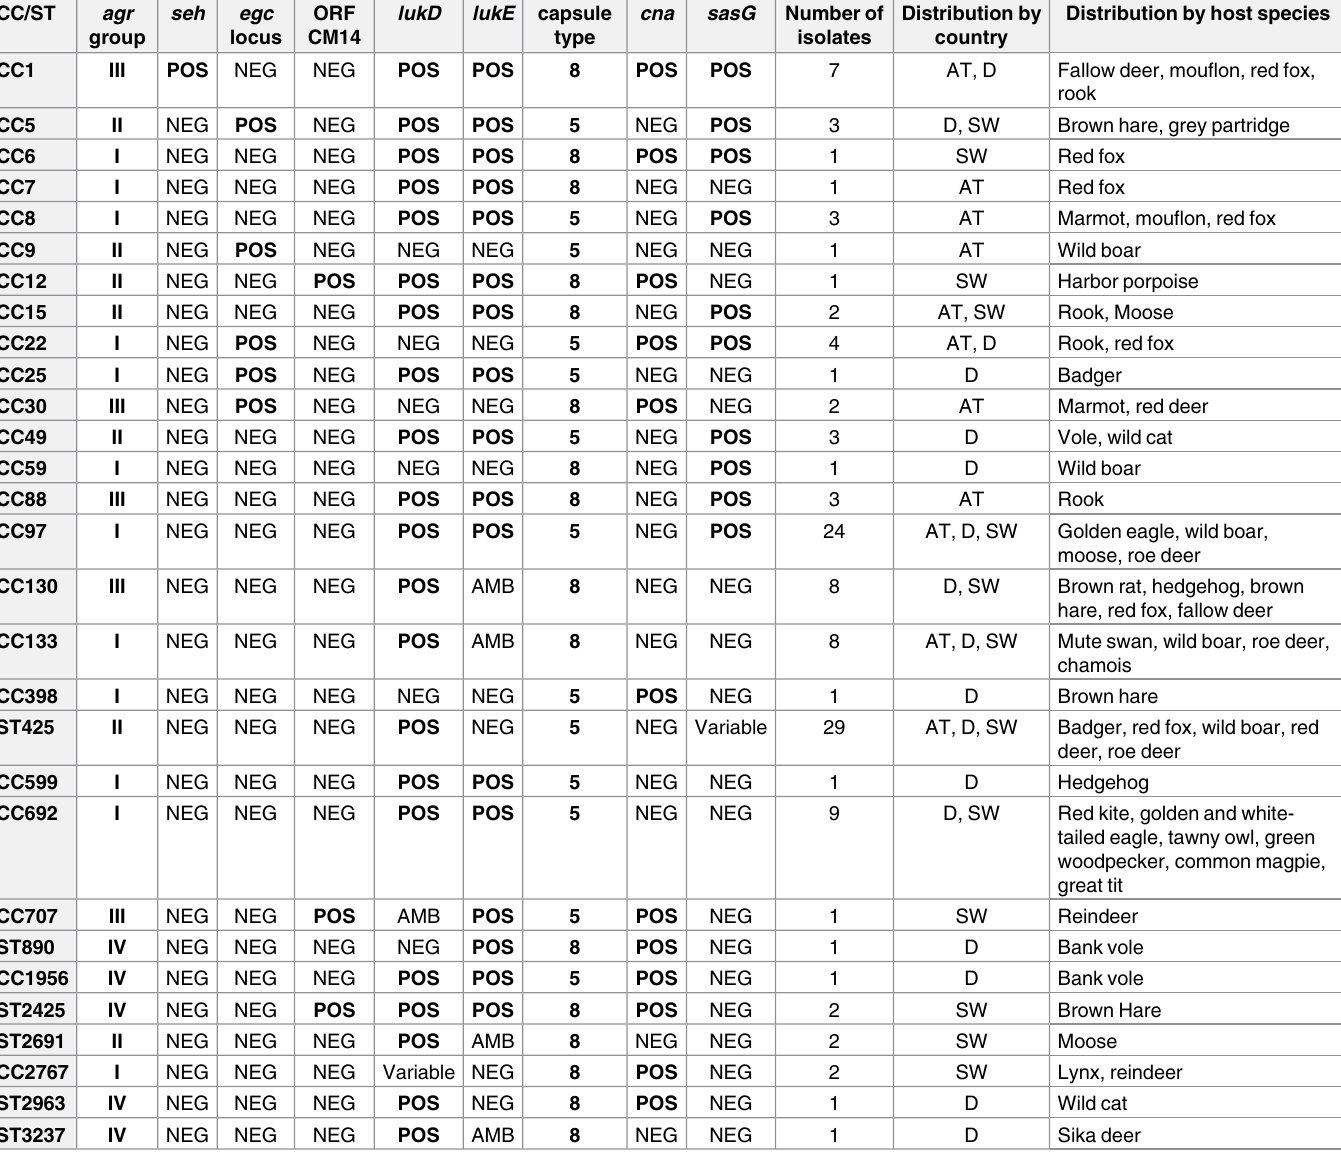
Table 2. CC/ST characteristics of S . aureus isolates